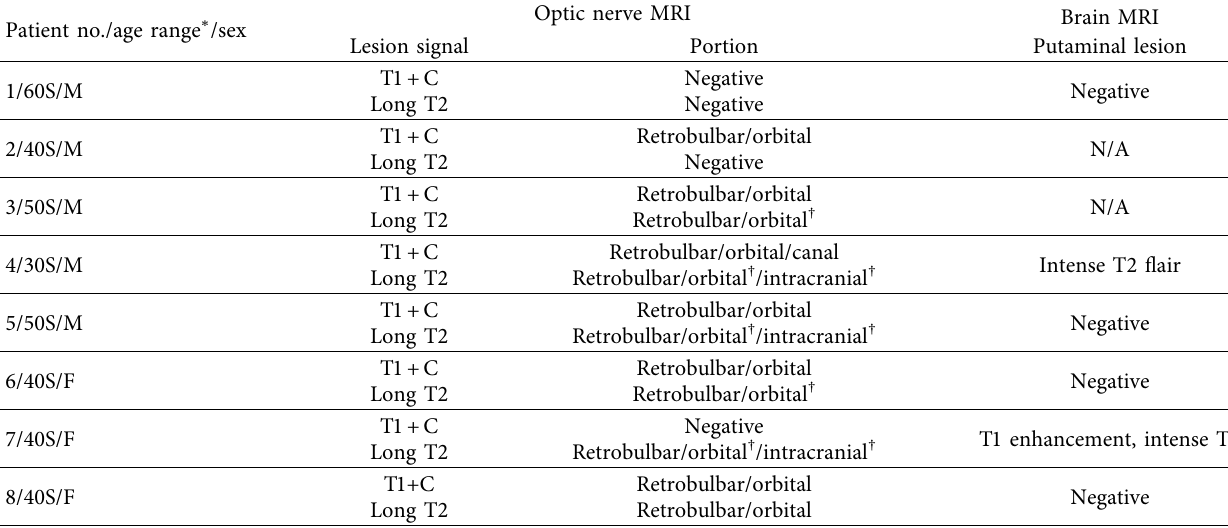
Table 3: Characteristics of optic nerve MRI and brain MRI.